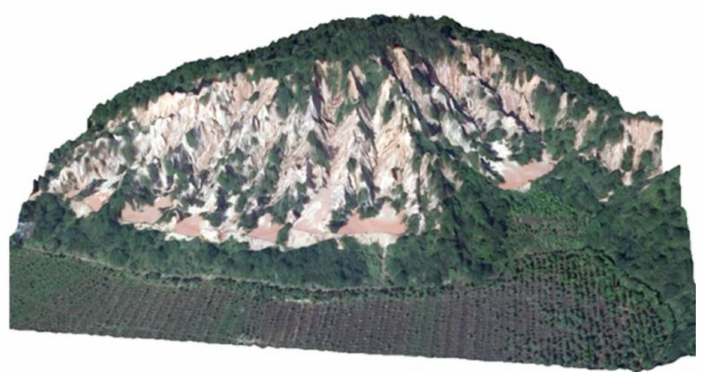
Figure 2. 3D view of a benggang area (produced by ArcScene using DOM and DSM